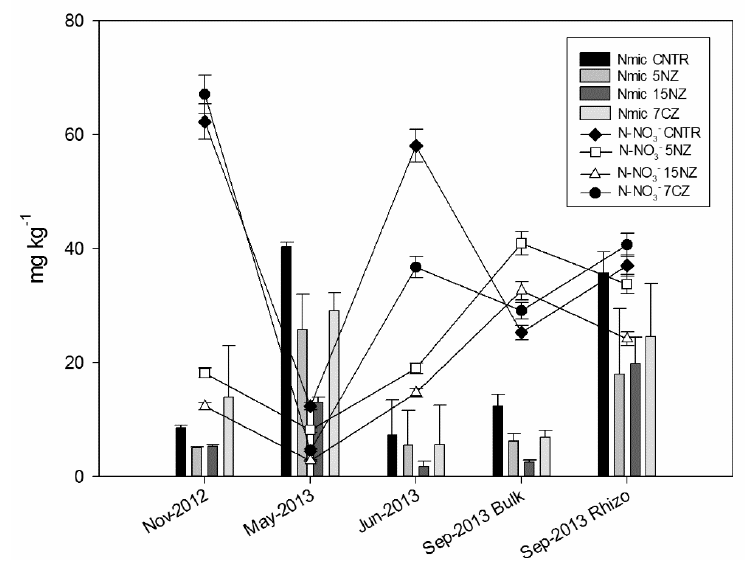
Figure 4. N mic (columns) and N-NO 3- (lines) content of soil samples across the monitoring period.